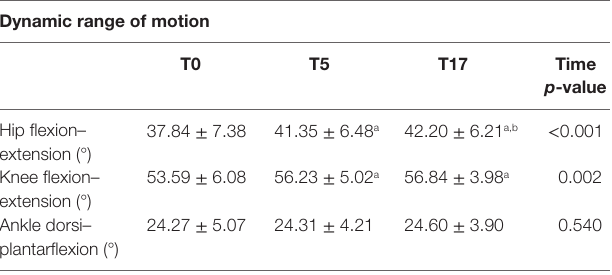
Table 5 | comparison between dynamic rOM assessed before and after